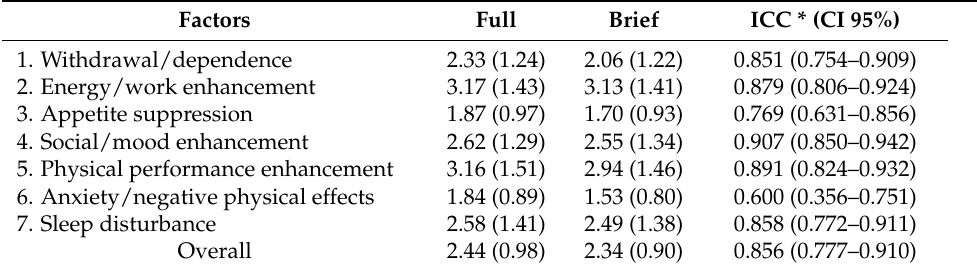
Table 2. Means (DP) and intra-class correlation coefficients (ICC) between scores of the CaffEQ-BR full and brief versions ( n =